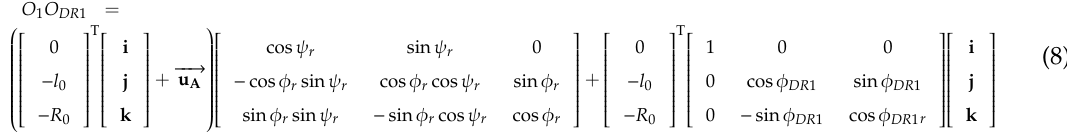
Figure 10. Solving method of